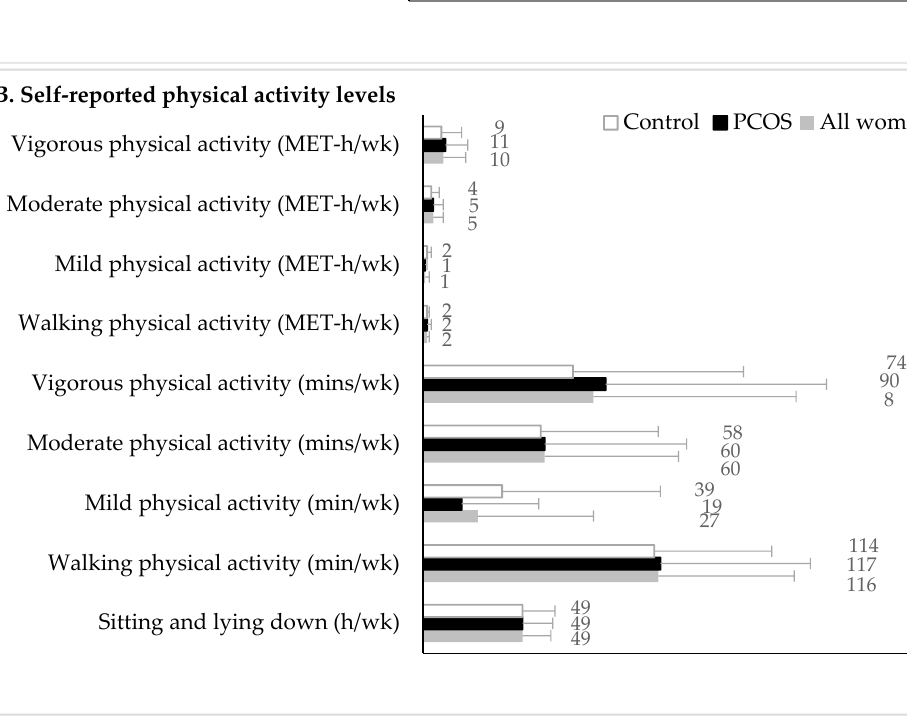
Figure 1. Physical activity levels of women with polycystic ovary syndrome and controls. Physical activity levels measured by accelerometry are shown in Panel A ( n = 82 women; n = 48 in the PCOS and n = 34 in the control group). Physical activity levels measured by the Women’s Health Initiative Study Physical Activity Questionnaire are shown in Panel B ( n = 101 women; n = 62 in the PCOS and n = 39 in the control group). Data are expressed as the mean and standard deviation. Physical activity levels were not different between groups in the crude models and after adjusting for age and body mass index differences and the number of comparisons (all: p ≥ 0.14). Abbreviations: PCOS, polycystic ovary syndrome; MET, metabolic equivalent task.